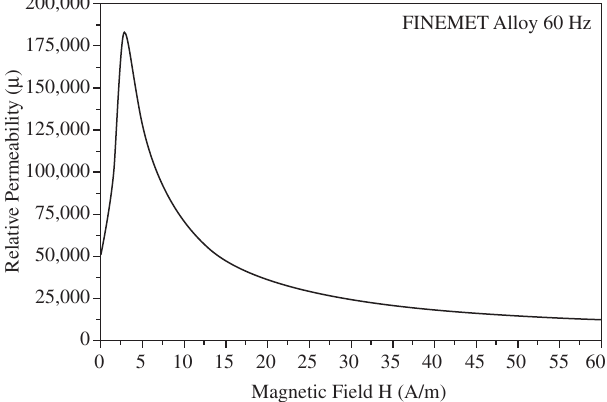
Figure 5. Magnetic permeability curve at 60 Hz.